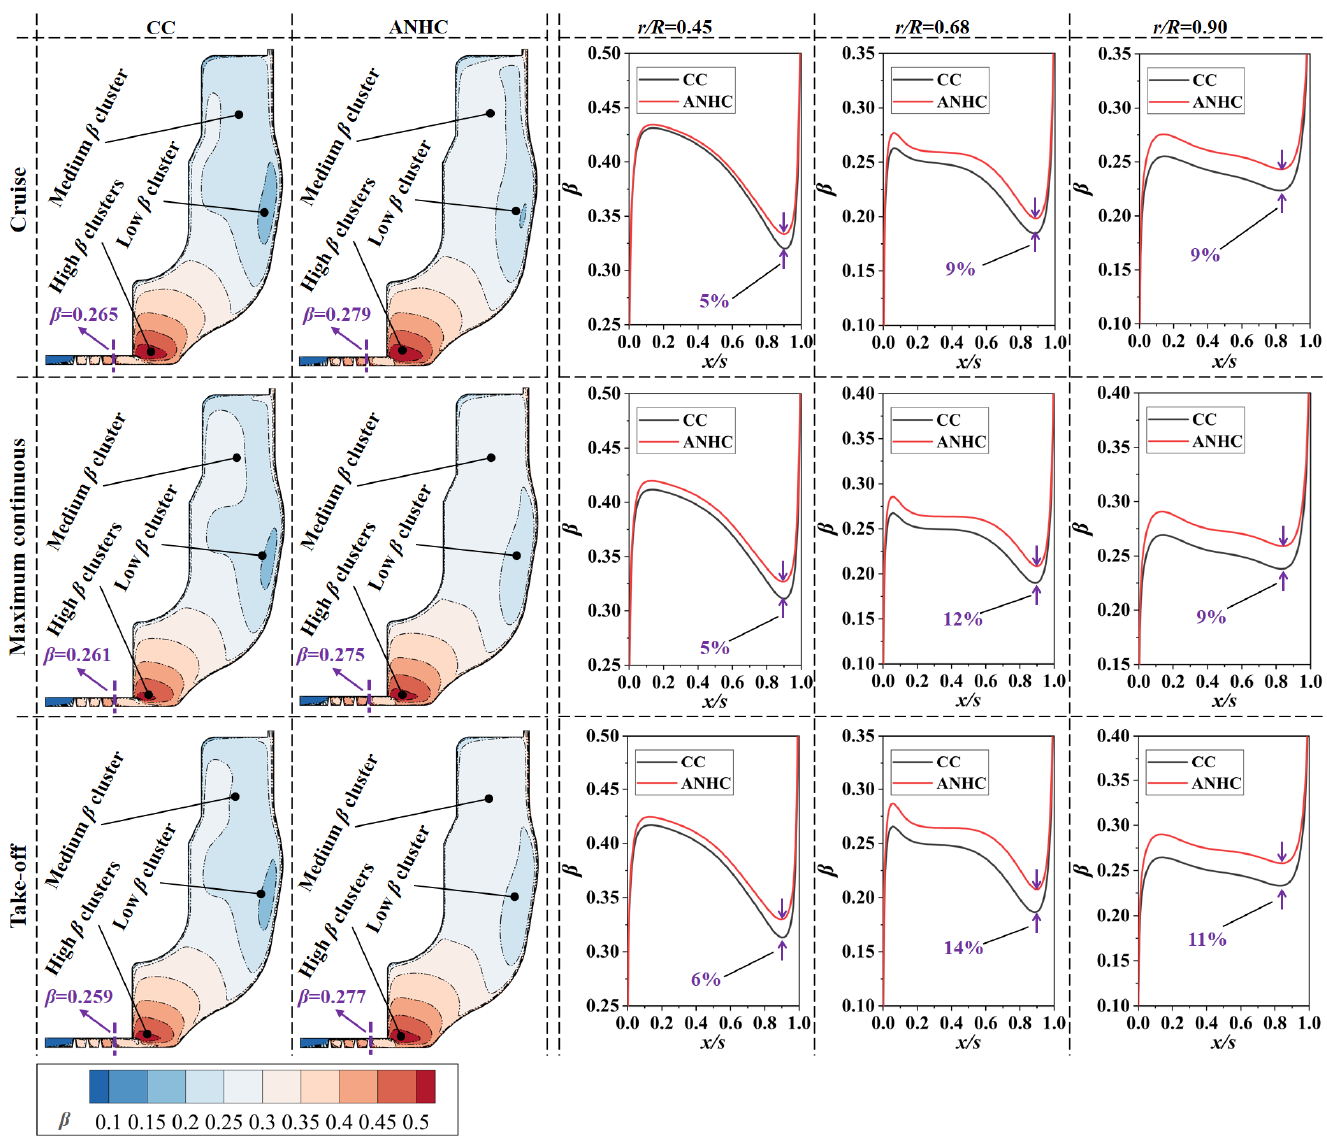
Figure 16. Swirl ratio distributions under CC and ANHC.